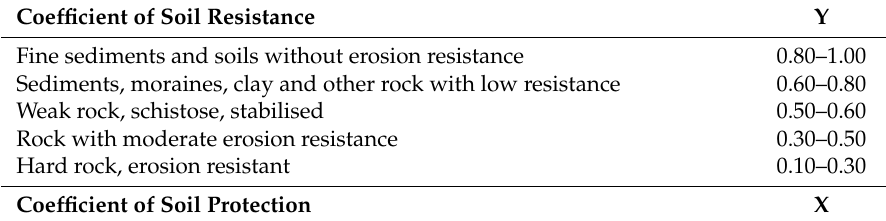
Table 2. Descriptive variables used in the erosion coefficient (Z) by EPM model.